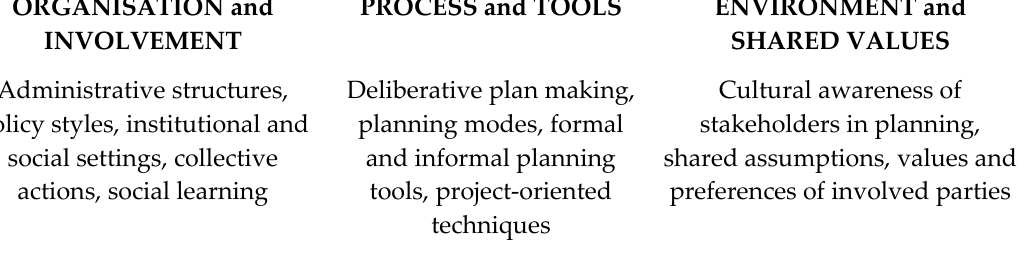
Figure 1. The framework for case studies.